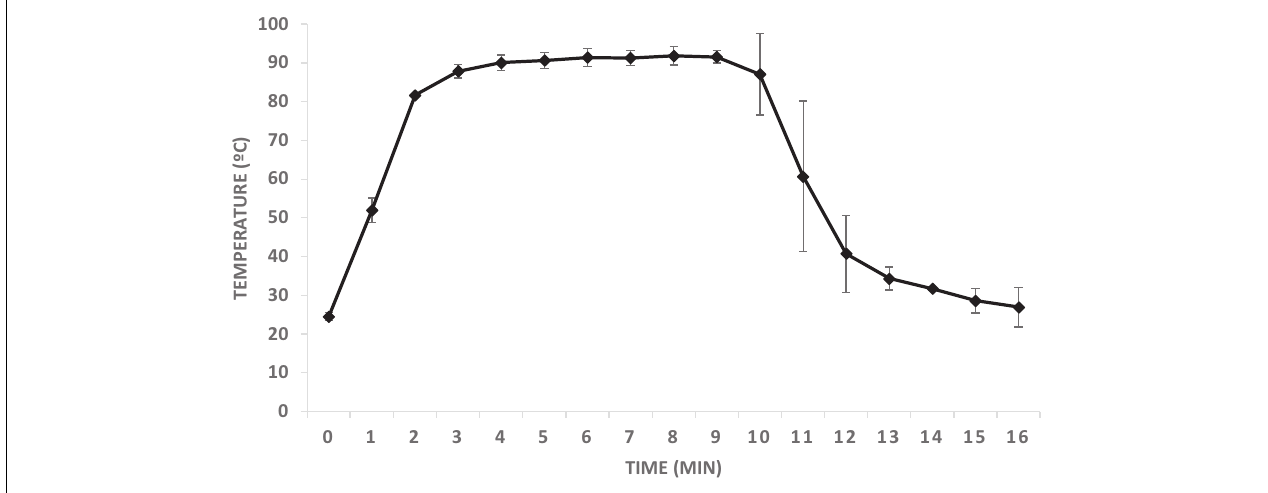
FIGURE 1 | Temperature monitoring during the inactivation process. Data correspond to average ± standard deviation calculated from three independent experiments.